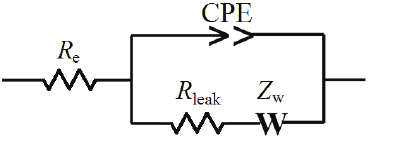
Fig. 7 – Randles equivalent circuit used to fit impedance